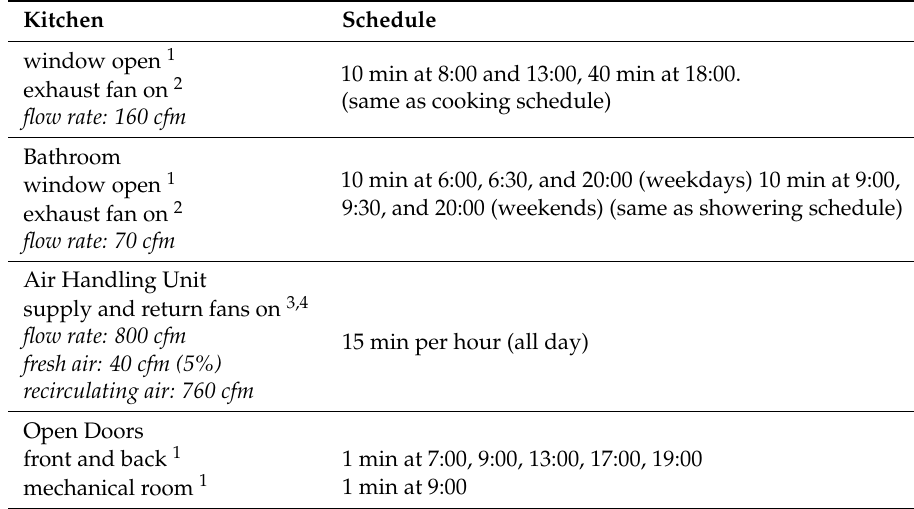
10 min at 8:00 and 13:00, 40 min at 18:00. (same as cooking